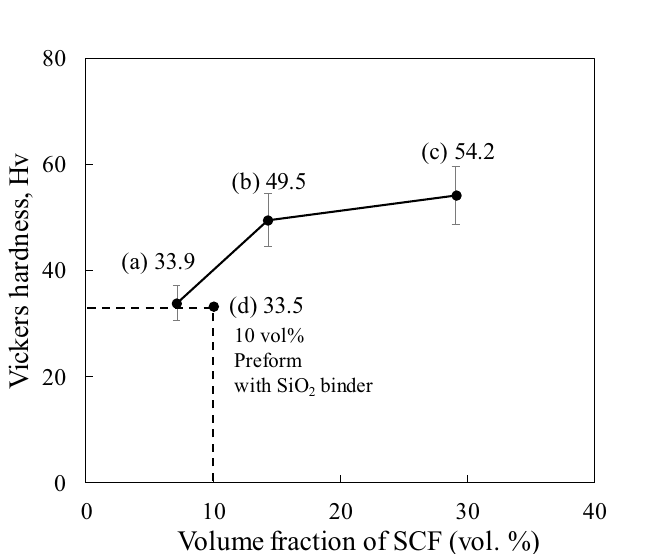
Figure 8. Image mean free path (IMFP) of SCF/Al composites with different volume fractions of short carbon fiber.